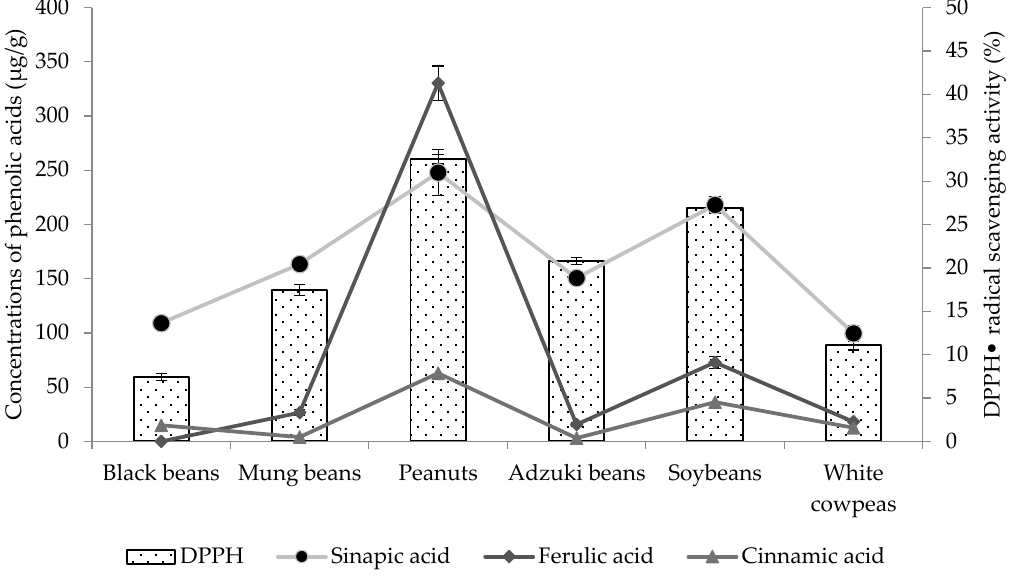
Figure 2. Correlation between 1,1-diphenyl-1-picrylhydrazyl (DPPH•) radical scavenging activity and concentrations of detected phenolic acids.